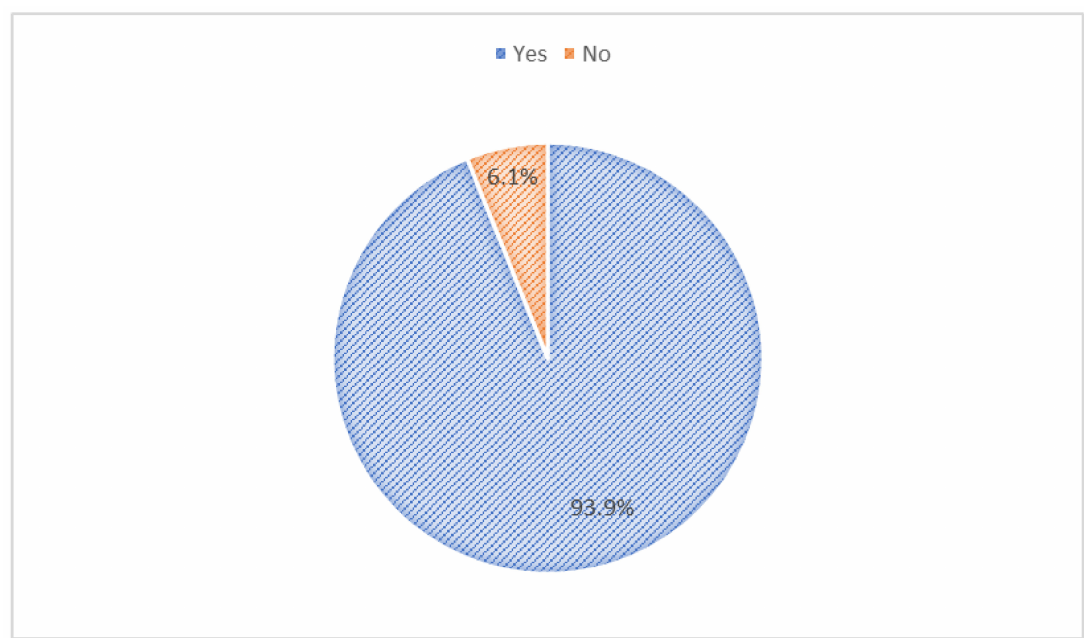
Figure 3. The ability to modify the features of mHealth apps to meet personal health goals.